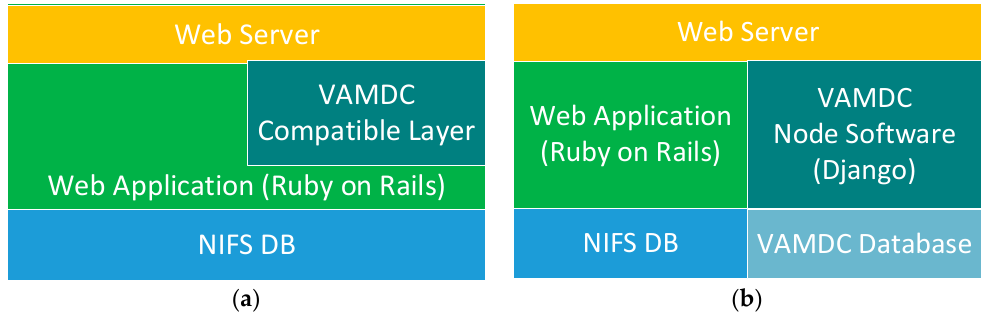
Figure 3. The results of the search can be obtained in the form of ( a ) numerical data, ( b ) images (PostScript, PDF, PNG), or the coefficients of fitting curve.